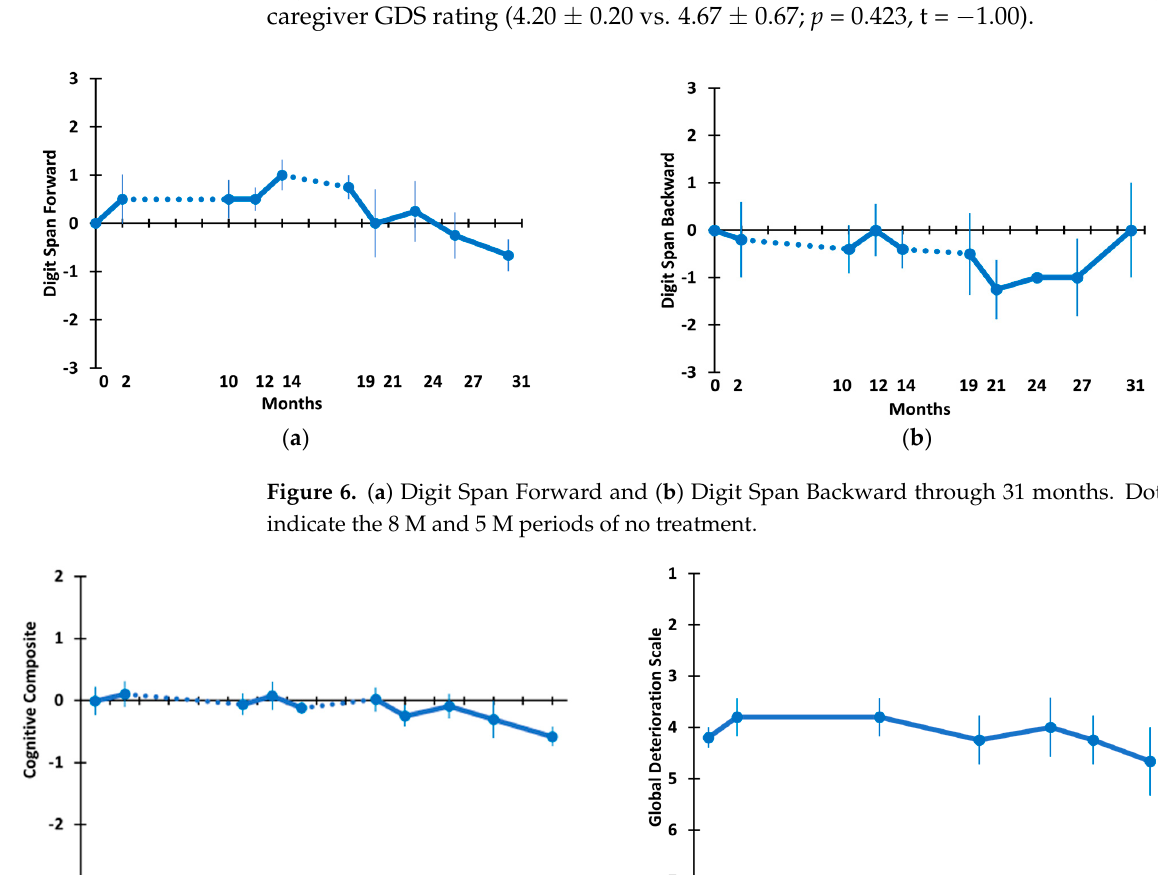
( b ) Figure 5. ( a ) Mini-Mental State Exam (MMSE) and ( b ) Activities of Daily Living (ADL). Dotted lines indicate the 8M and 5M periods of no treatment. For both the MMSE and ADL graphs, the red data points are from earlier clinical studies evaluating these two measures longitudinally in untreated mild/moderate AD subjects. SEMs were not available from either earlier study. The profile of ADL scores in TEMT-treated AD subjects paralleled that of MMSE scores over a 27M period (Figure 5b). Specifically, a drop in ADL scores during the 8M period of no treatment was followed by the stabilization of ADL scores with the re-initia- tion of treatment at 10M. Longitudinal ADL scores from untreated mild/moderate AD subjects in an earlier study [36] are shown for comparison in Figure 5b ( n = 89; mean MMSE score at baseline = 19.0). The demographics and baseline ADL scores from this earlier study were comparable to those of the present study. The stabilization in ADL